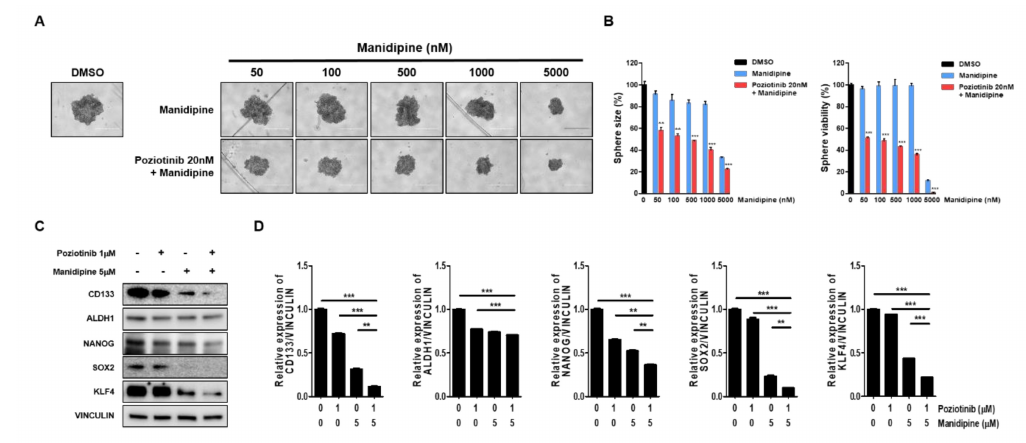
Figure 3. The e ff ects of poziotinib and manidipine, alone or in combination, on ovarian CSC growth and expression of stemness markers. ( A ) A2780-SP cells were treated with poziotinib and manidipine at the indicated concentrations for 6 days. Representative image of spheres after 6 days of treatment. ( B ) Sphere size (left panel) quantitation and viability (right panel). The data are expressed as the mean ± SD of two or three independent experiments. ** p < 0.01, *** p < 0.001. ( C ) Protein expression levels of stemness markers were detected by Western blotting. A2780-SP cells were treated with poziotinib and manidipine at the indicated concentrations for 24 h. ( D ) The results of the Western blot are shown in a graph. The data are expressed as the mean ± SD of three independent experiments. ** p < 0.01, *** p <